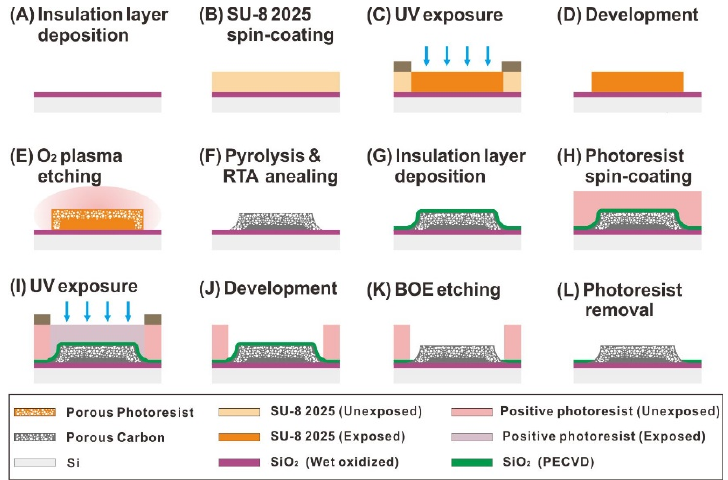
Figure 1. Schematic of the fabrication steps for hierarchical nanoporous carbon electrodes (PR, photoresist; RTA, rapid thermal annealing; BOE, buffered oxide etch).